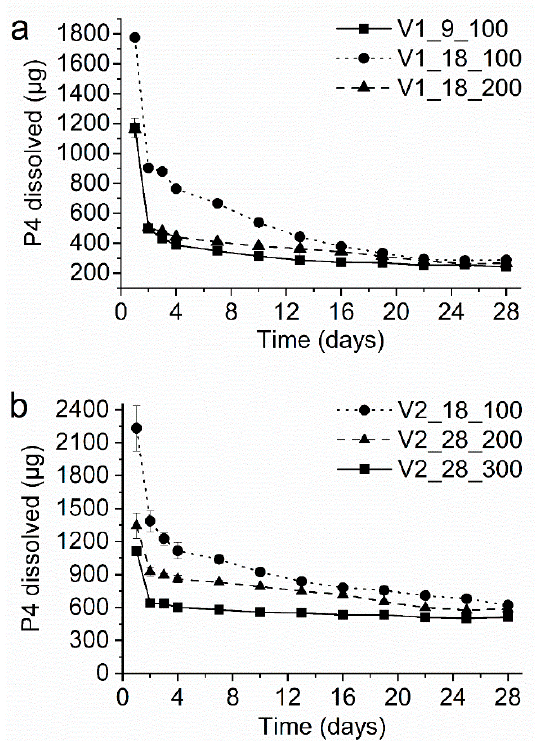
Figure 6. In-vitro progesterone (P4) dissolution profile of the vacuum compression molding (VCM) systems comprising ( a ) EVA28 as core polymer and ( b ) EVA40 as core polymer. The y-axis shows the amount of P4 released per day. Table 2. In-vitro progesterone (P4) dissolution data generated from the VCM systems. *The average daily release was calculated between day 3 and day 28. **Predicted values using the equilibrium P4 solubility in the core polymer and the measured membrane thickness in Equation (2) (Section 3.4 and 4.5).